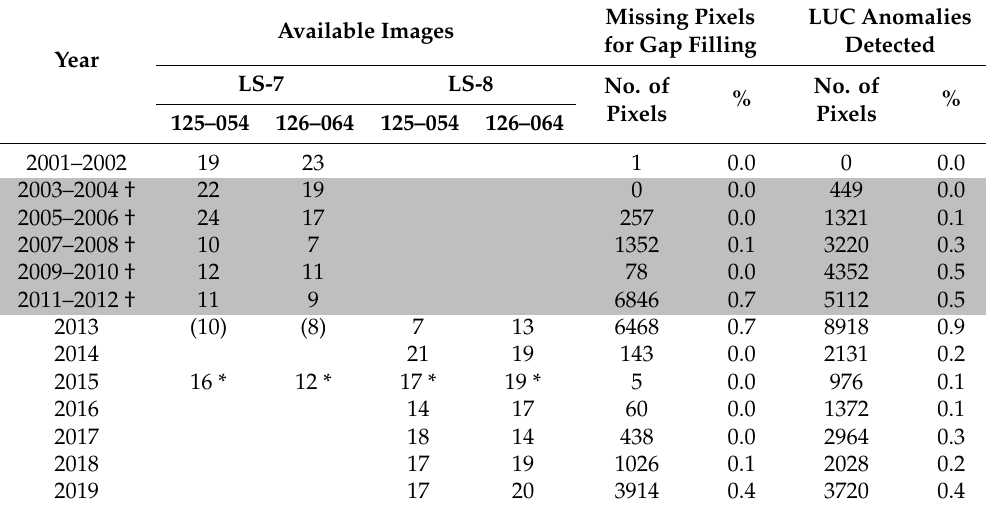
* = Training year, † = Scan Line Corrector (SLC)